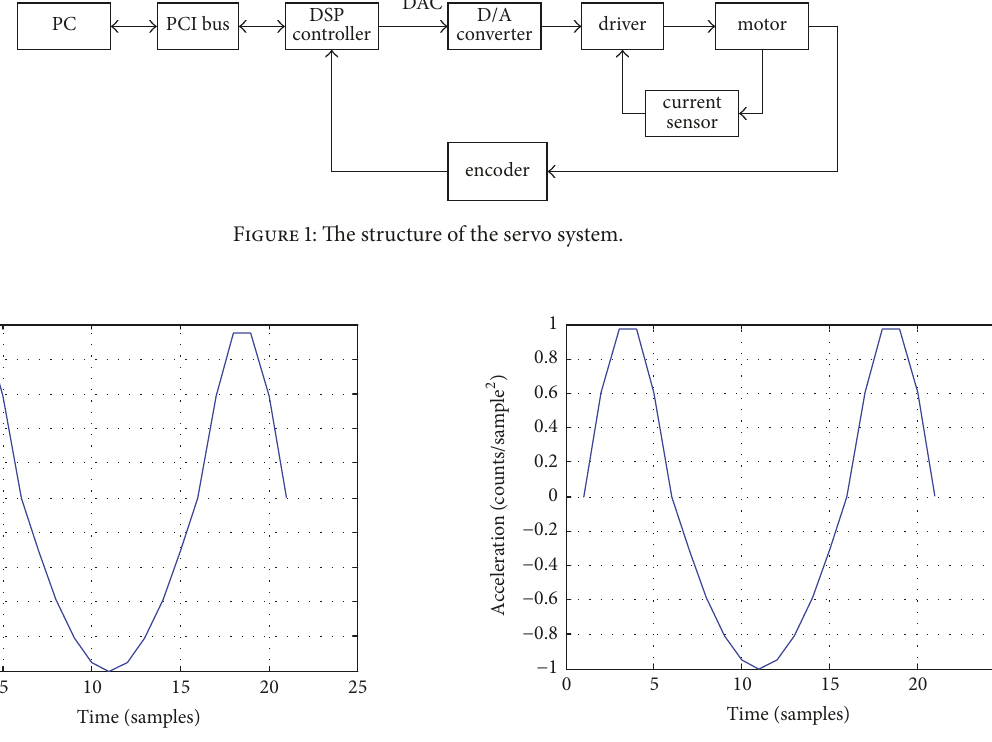
Figure 2: The waveform of exciting DAC. Figure 3: The acceleration waveform of the system.